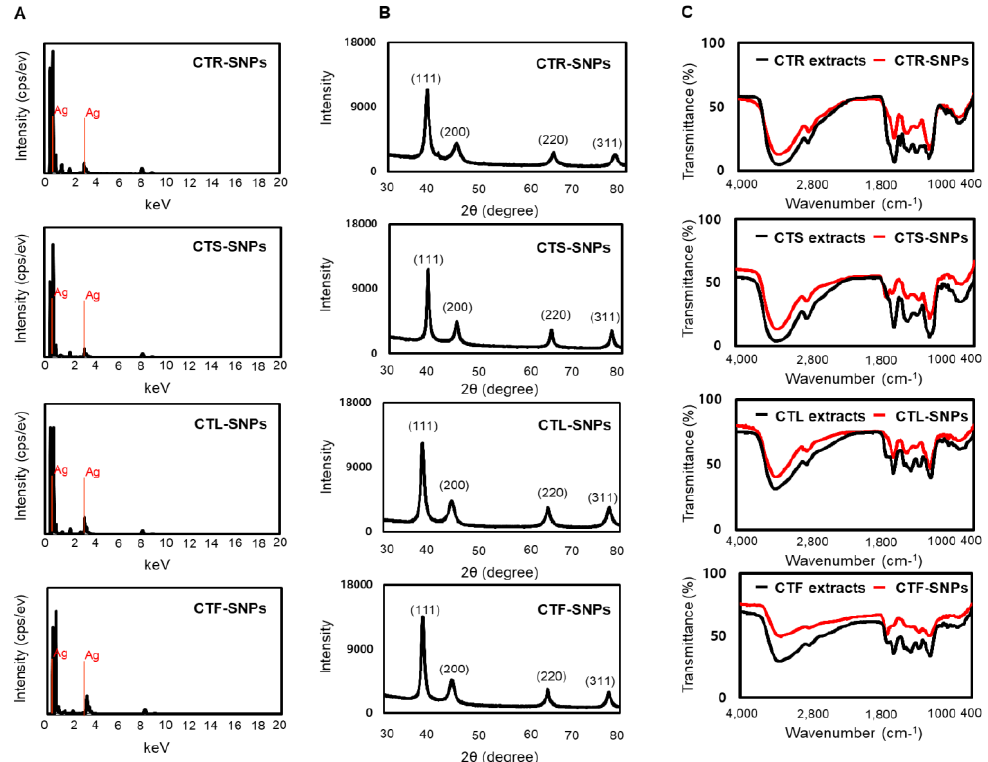
Figure 4. ( A ) EDS analysis, ( B ) XRD pattern, and ( C ) FTIR spectra of CTR, CTS, CTL, and CTF-SNPs.